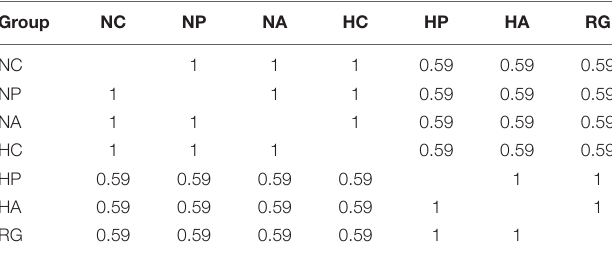
Outcome of invariance analysis between the mental structures of each group. NC, novices group within childhood; NP, novices group within pubescence; NA, novices group within adolescents; HC, handball group within childhood; HP, handball group within pubescence; HA, handball group within adolescents; RG, reference group, λ crit =